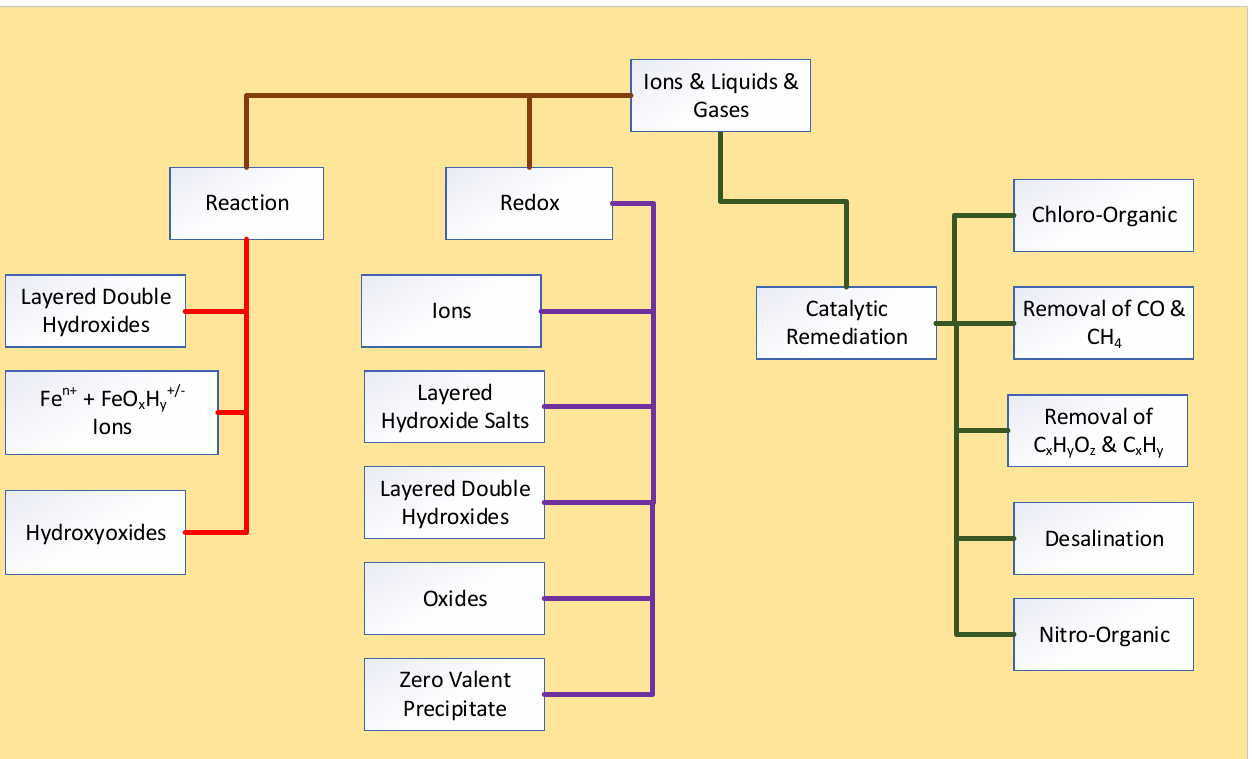
Figure A9. Remediation reaction routes resulting from water treatment with Fe 0 .